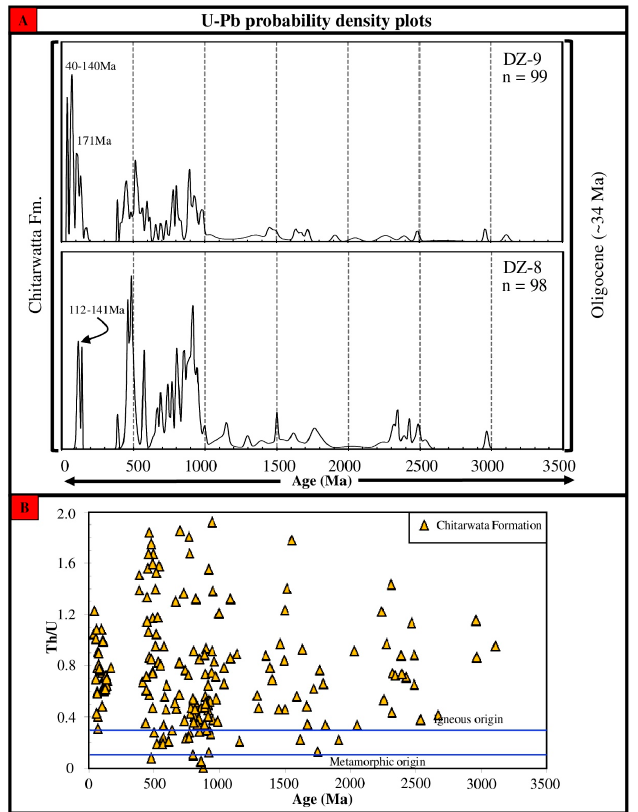
Figure 5. ( A ) Probability density plots of the U–Pb ages of detrital zircon samples representing the Cenozoic sequence, Mughalkot section, Sulaiman fold–thrust belt. ( B ) The binary plot showing the U–Pb detrital zircon ages and Th/U ratio, reflecting igneous and metamorphic zircons.